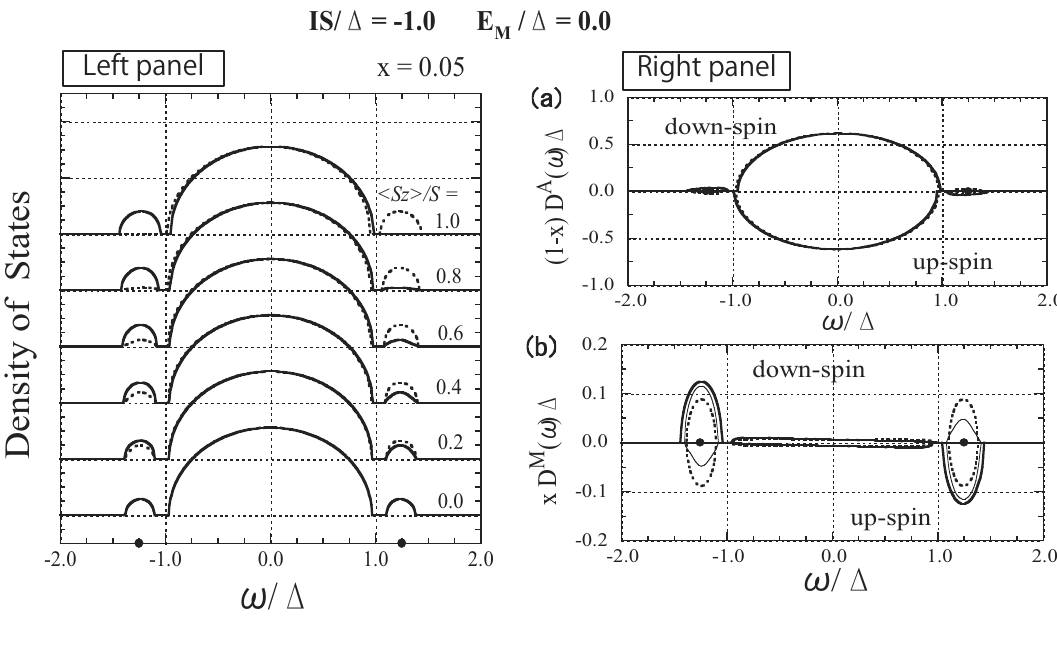
Figure 4. Left panel: DOS as a function of != ∆ for various values of ⟨ S ⟩ =S . The solid lines represent the down-spin carrier and dotted lines z represent the up-spin carrier. The impurity levels E by dots on the abscissa. Right panel: (a) A -site component of the